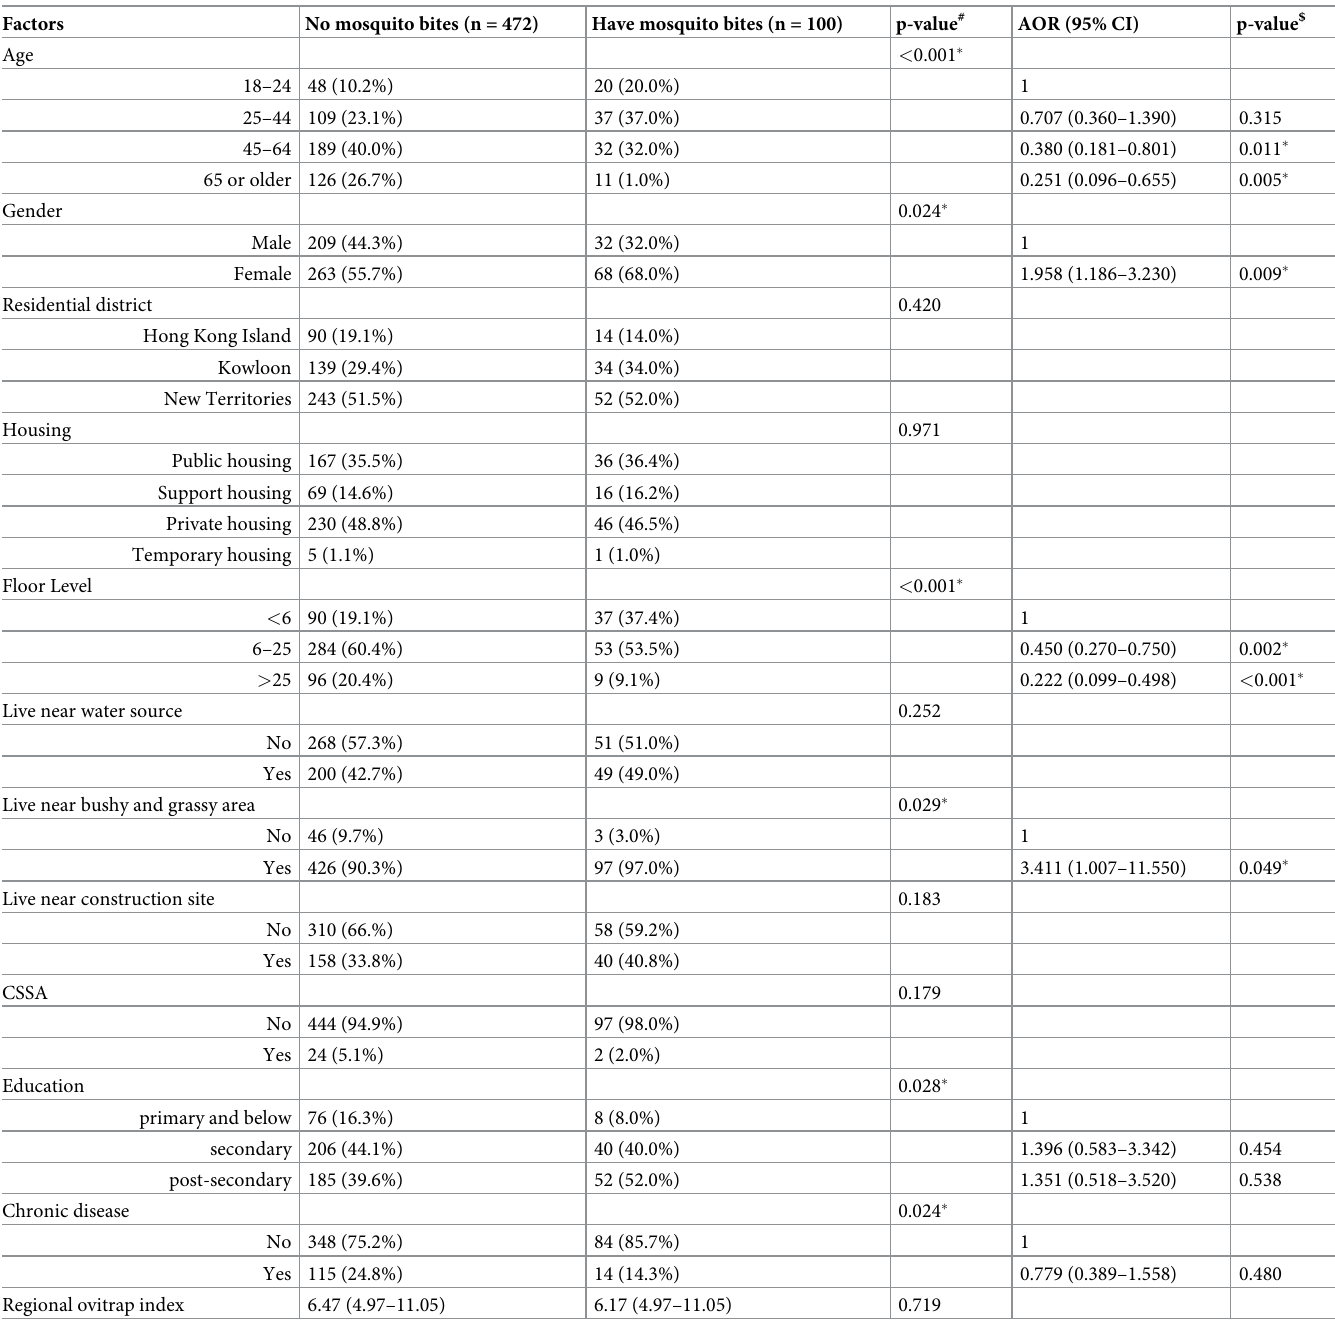
Table 2. Associated factors of mosquito bites at